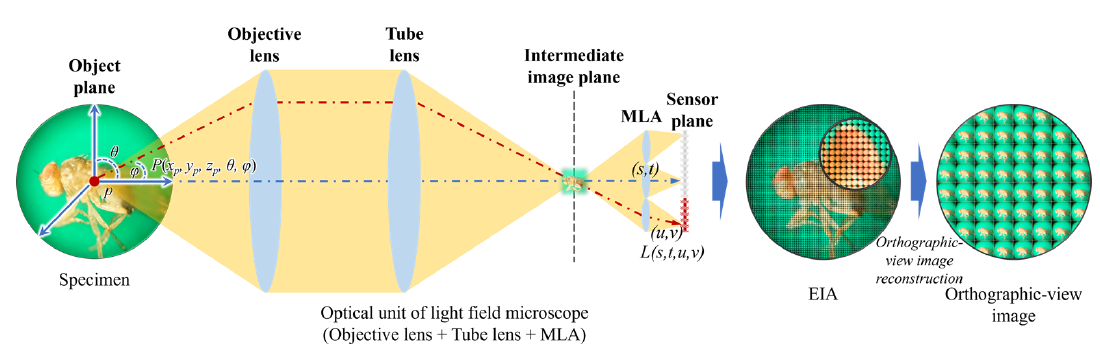
Figure 1. The main acquisition and reconstruction processes of the LFM